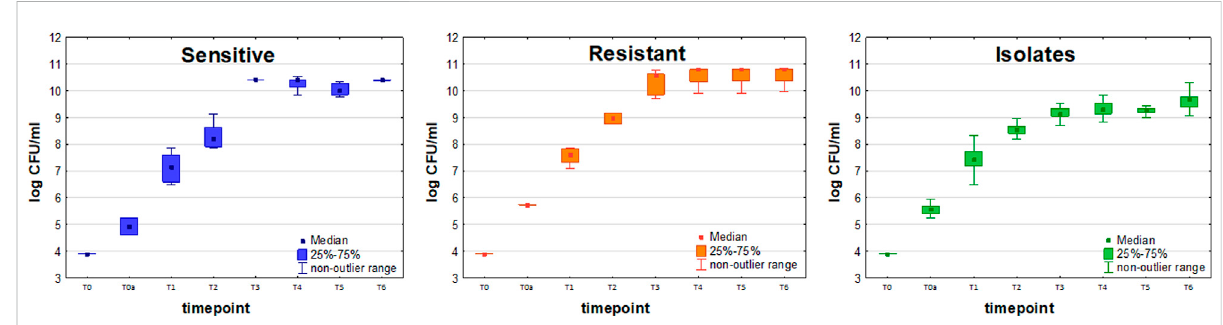
FIGURE 2 Growth curves of sensitive (blue boxes, n = 6), resistant (orange boxes, n = 9) and clinically isolated (green boxes, n = 23) strains of Klebsiella pneumonia . Colony Forming Units (CFU/ml) are plotted after logarithmic transformation in the function of incubation time.